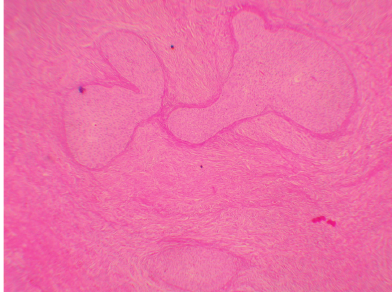
Figure 3: Appearance of Brenner tumor of ovary (hematoxylin and eosin staining